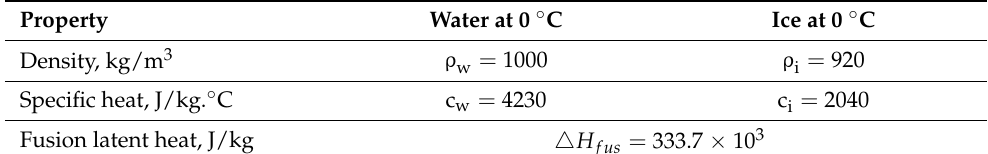
Table 4. Properties of the distilled water (PCM) from Incropera 1996 [23]. Property Water at 0 ◦ C